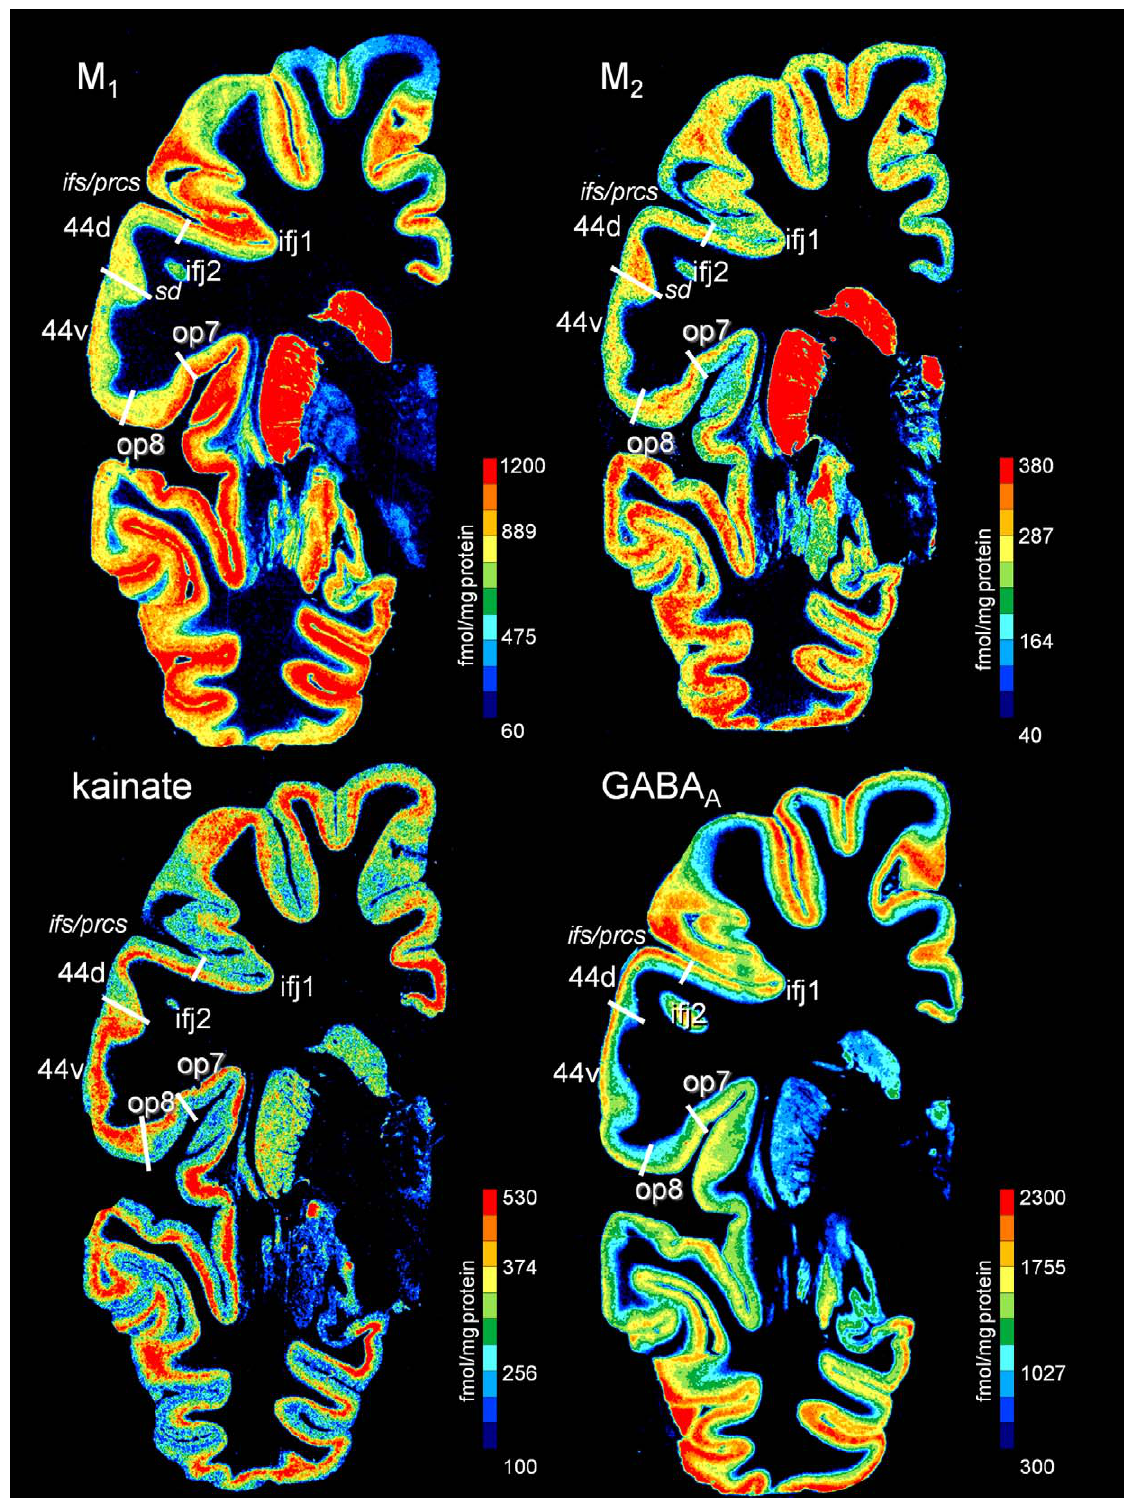
Figure 7. Receptor mapping in whole hemispheric human brain sections. Distribution of the cholinergic muscarinic M 1 and M 2 receptors, the glutamatergic kainite, and GABA-ergic GABA A receptors in a neighboring coronal sections of a complete human hemisphere (level 32). The receptor concentrations are indicated in fmol/mg protein and color coded according to the color bar on the right of each section. Designation as above.